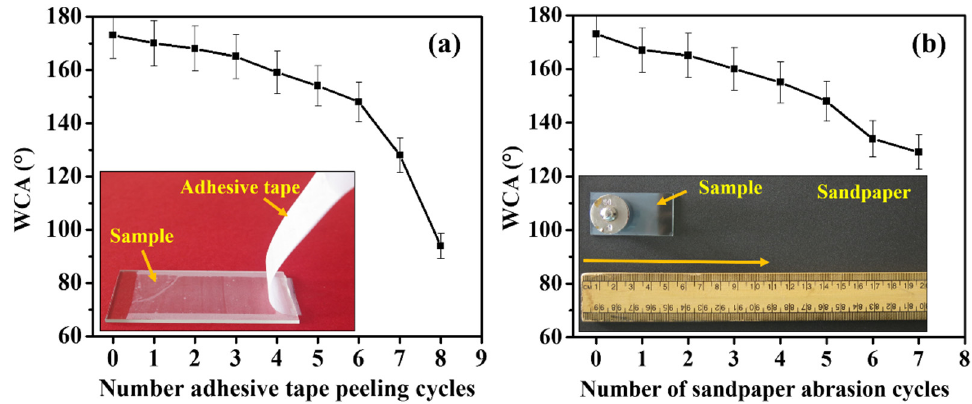
Figure 4. ( a ) An adhesive tape peeling test and ( b ) a sandpaper abrasion test on the AD-2